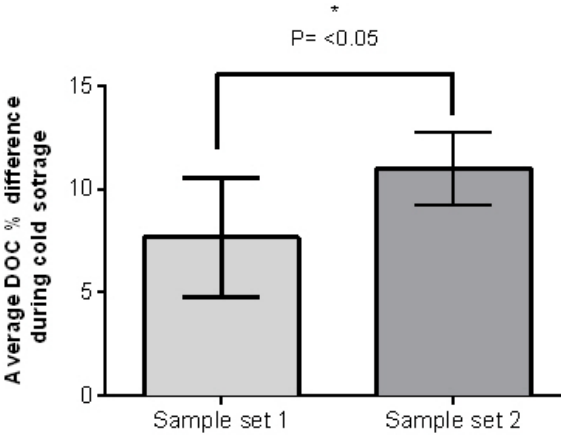
Figure 4. Average normalised % differences in DOC observed, for the same sample, before and after approximately 12 weeks of cold storage (4 °C), for both sample sets in Experiment 2. DOC concentrations were calculated using the two- wavelength approach (Carter et al . 2012). Error bars show the standard error of the mean. The significance of differences is also shown (unpaired two-tailed t-tests, n =